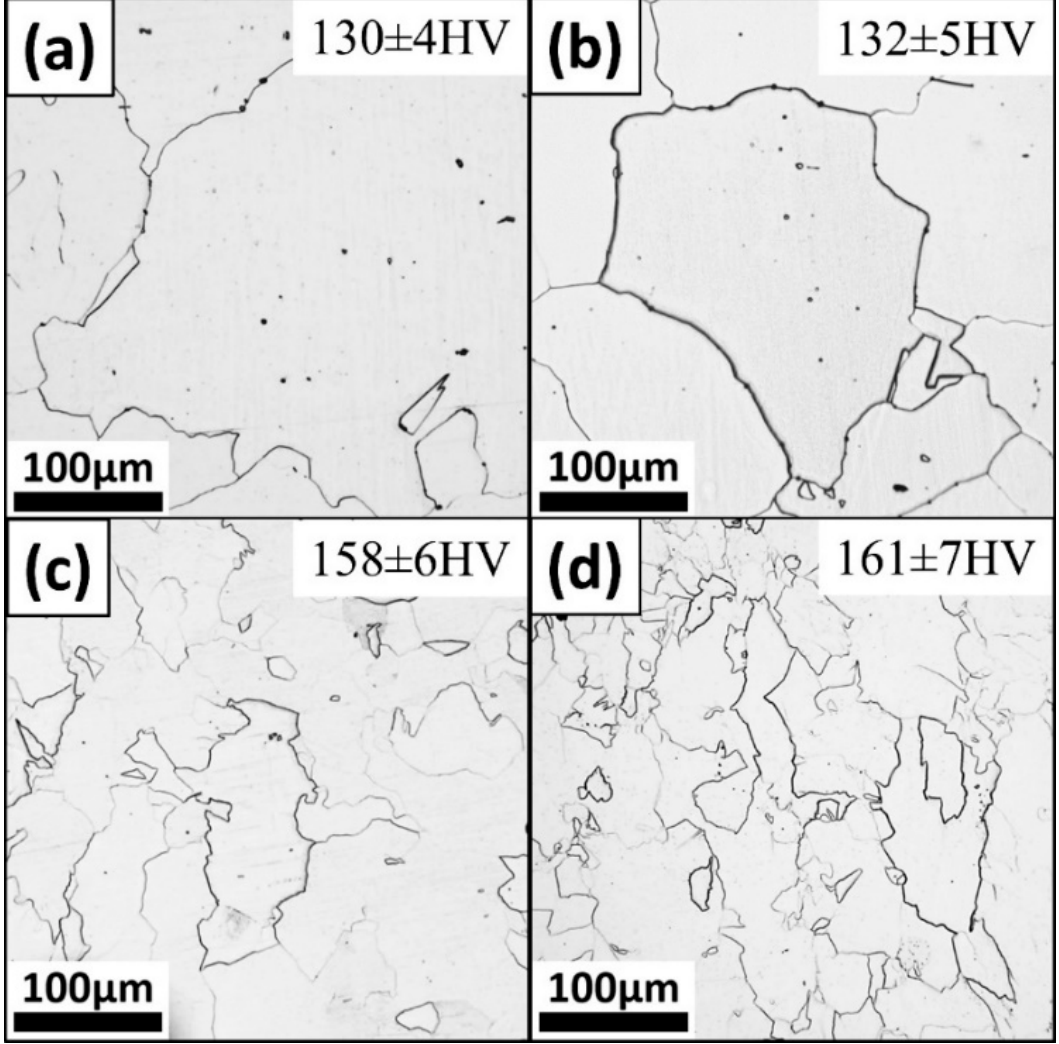
Figure 2. ( a , b ) optical micrographs of allotriomorphic ferrite in the samples A (179 ± 13 µ m) and B (138 ± 11 µ m), respectively; ( c , d ) massive ferrite in the samples A (63 ± 7 µ m) and B (46 ± 6 µ m), respectively.